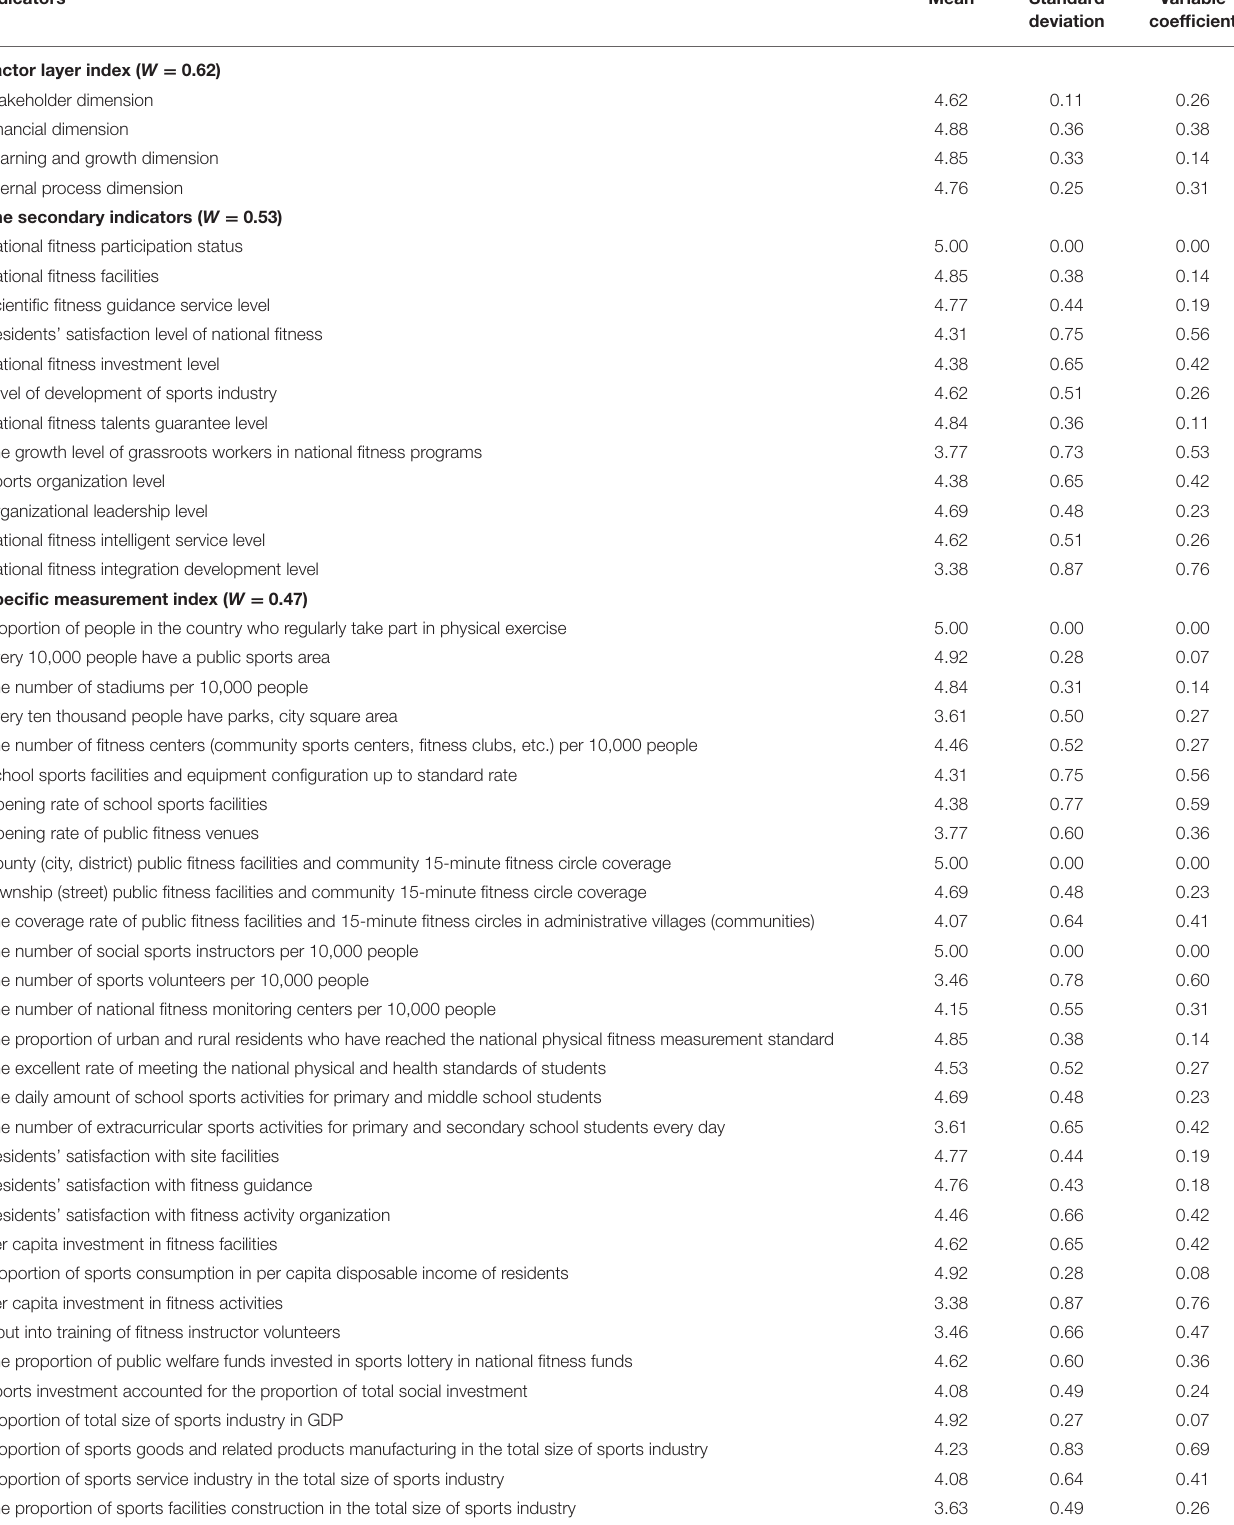
Variable deviation coefficient